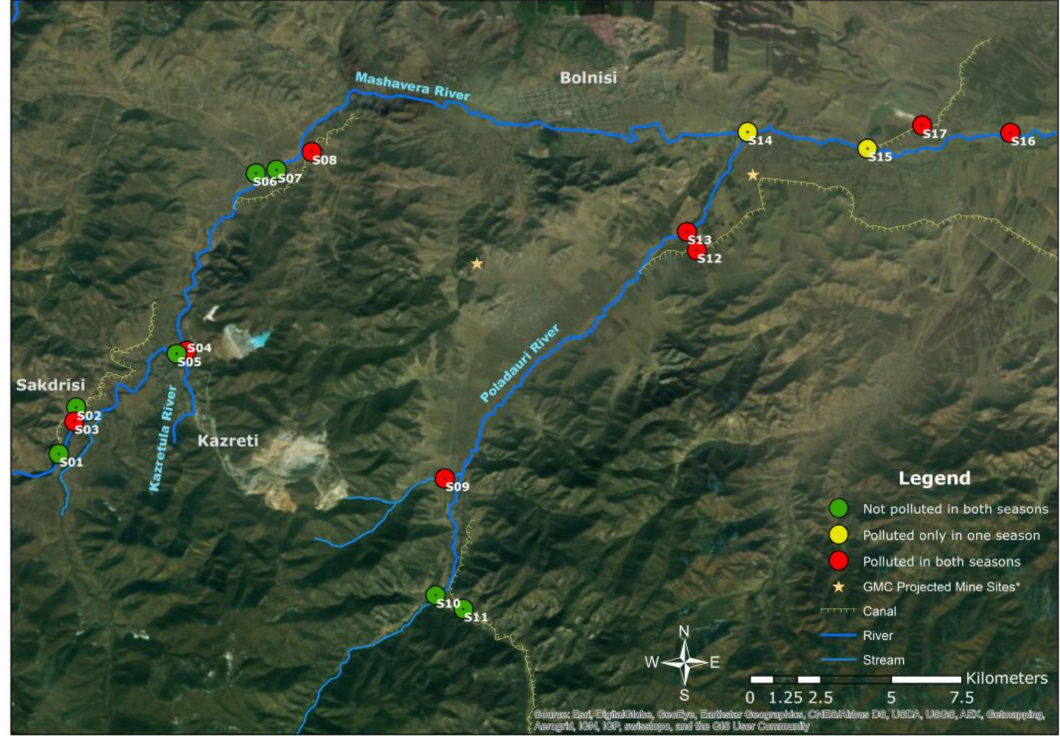
Figure 5. Spatial assessment of Pollution Load Index (PLI) for both seasons (Authors’ illustration). * GMC projected mine sites [59]; GIS Data source: 1. Land-use data and stream data [21] and 2. Base map from ESRI satellite image layer